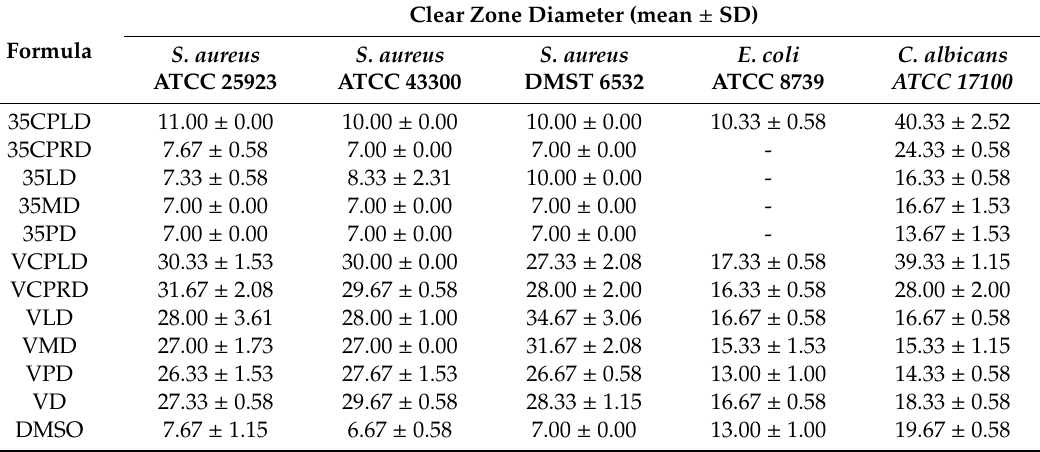
Table 4. Inhibition zone diameter of drug-free formulation, drug-loaded formulation, drug in DMSO and DMSO against S. aureus, E. coli , and C. albicans (triplicate testing; n = 3). (- : no inhibition zone).